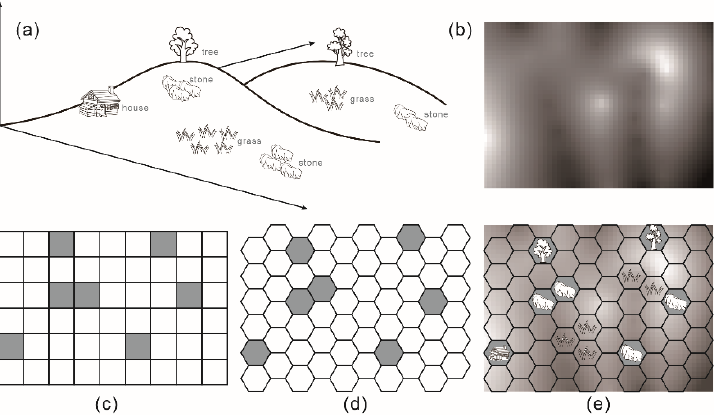
Figure 1. The details of the occupancy information grid model: ( a ) the spatial environment, ( b ) terrain characteristic, ( c ) occupancy grid map, ( d ) regular hexagonal grid model and ( e ) occupancy information grid model.